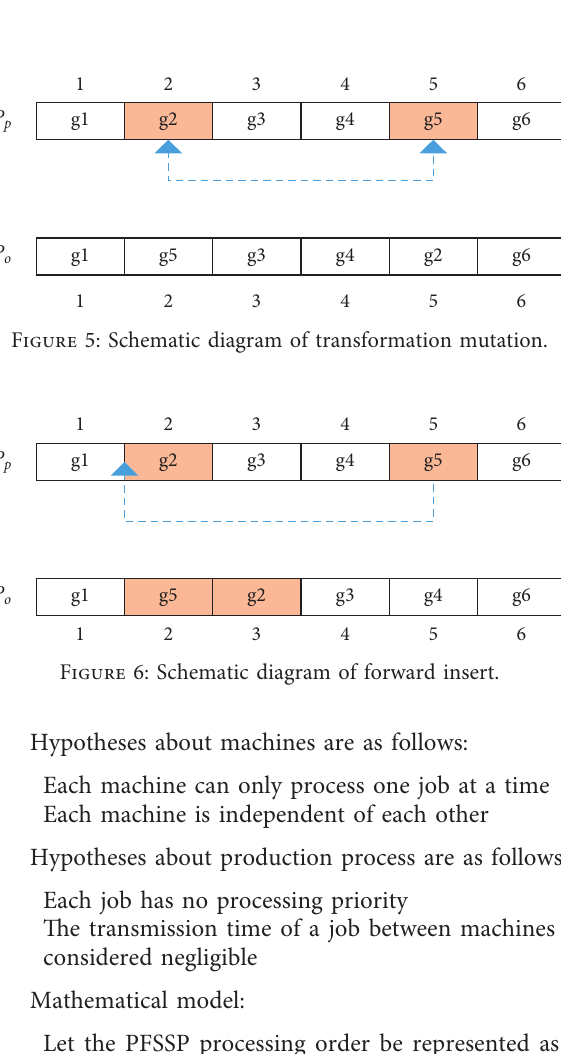
Figure 3: Schematic diagram of loop-based